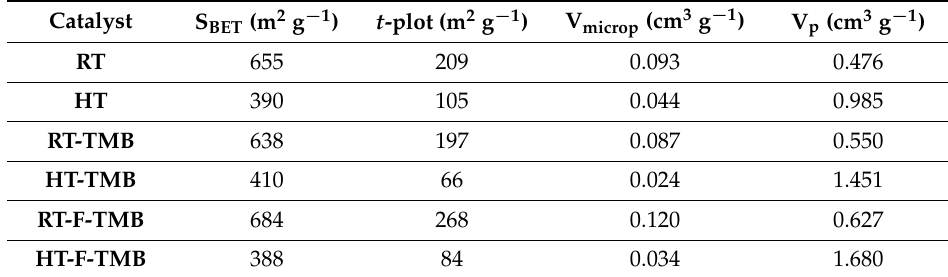
Table 1. Textural properties of the Zr-doped porous